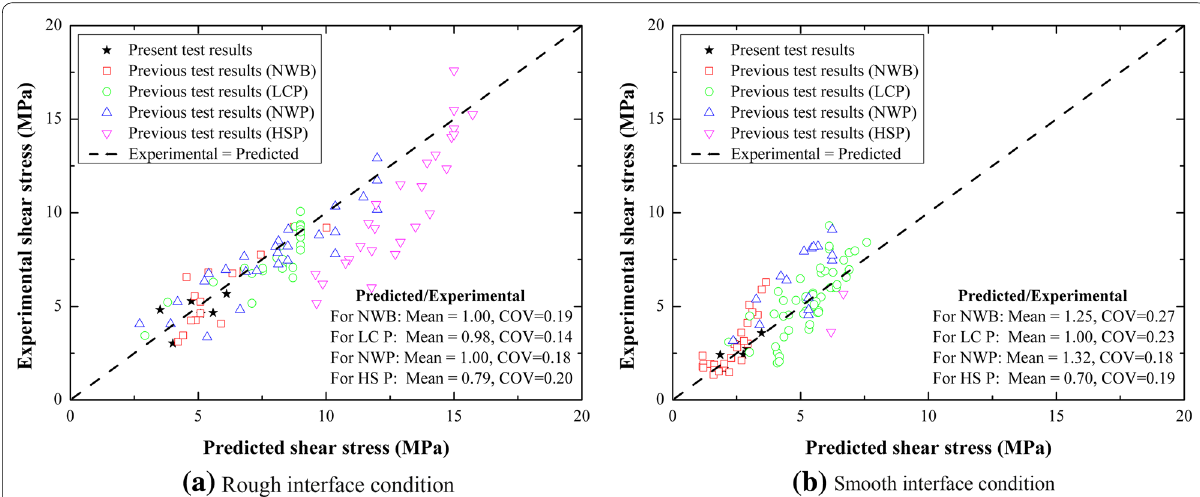
Fig. 12 Comparison of proposed equation with others’ experimental